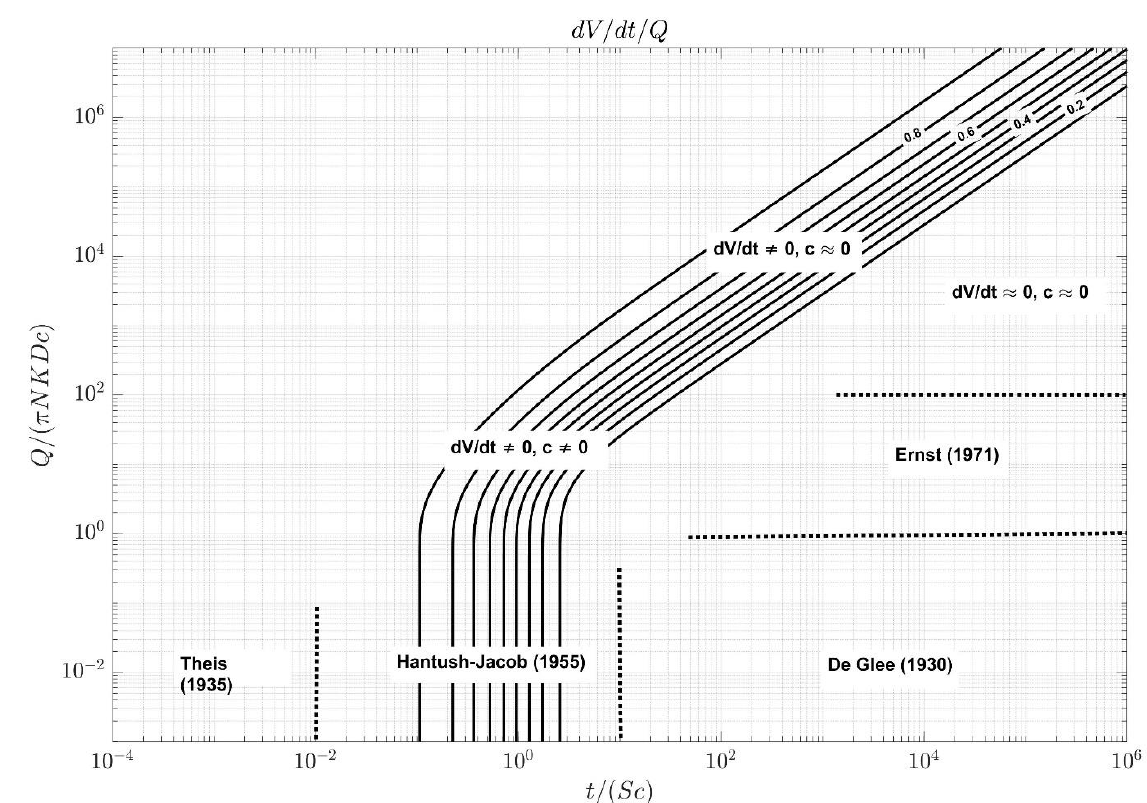
Figure 5. Contour plot of dimensionless storage change dV / dt / Q as a function of dimensionless time t /( Sc ) and dimensionless pumping rate Q /( π NKDc ) for the transient state solution of the Ernst model developed in this study, with dV / dt the storage change, Q the pumping rate, t the time, S the storage coefficient, c the drainage resistance, N the infiltration flux, K the aquifer conductivity, and D the saturated thickness. See text for definitions. The dotted lines indicate the rules of thumb derived in this paper.